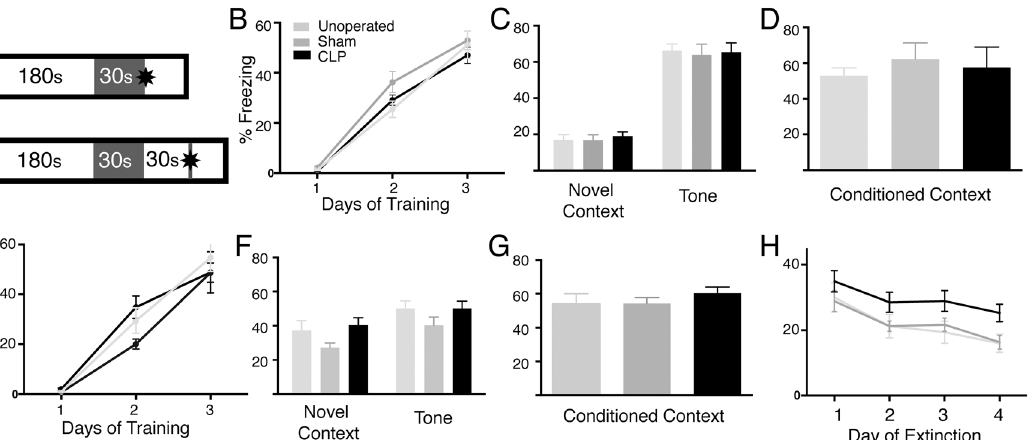
Fig 1. Sepsis survivor mice do not show a deficit in contextual fear conditioning or trace fear conditioning 50 days after CLP, but do demonstrate impaired extinction of conditioned fear. A: In a contextual fear conditioning paradigm, mice were placed in a defined context for 180 s (white bar) at rest. A tone was played for 30 s (gray bar), followed immediately by a foot shock (star). In the trace fear conditioning paradigm, a 30 s delay is introduced after the tone and before the administration of the foot shock. B: In contextual fear conditioning, there is no difference between the rate at which sepsis survivor and control mice associated the freezing response with the context. C: After three days of training, there was no difference in the response of post-CLP and control mice to the tone alone in a novel context. D: There was no difference among post-CLP and control mice in the freezing response to the conditioned context. E-G. In the trace fear conditioning paradigm, there were also no differences among groups in the acquisition of the freezing response, response to tone, or response to context. H. Post-CLP mice demonstrate increased freezing in the conditioned context compared to sham-operated and unoperated mice during repeated exposures without foot shock, indicated a deficit in extinction